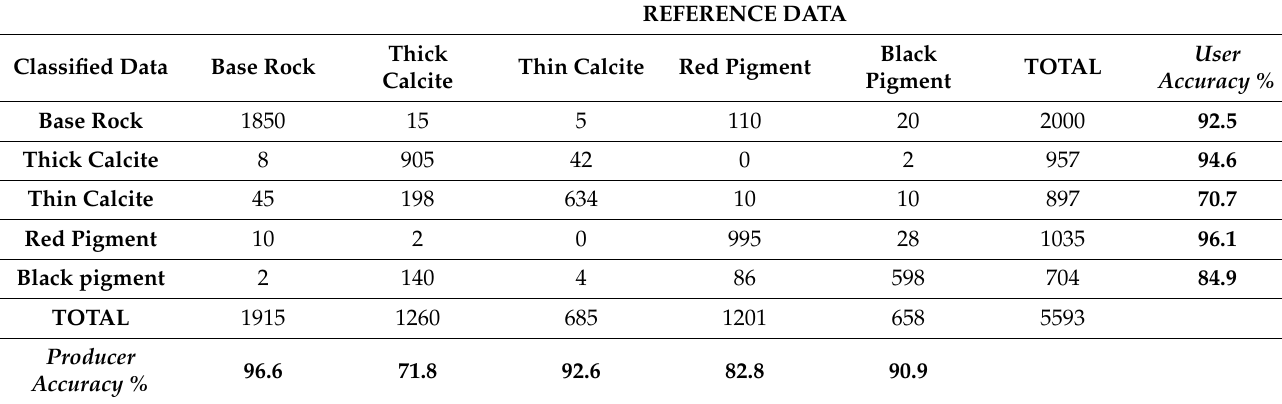
Table 1. Classified image producer and user accuracy.